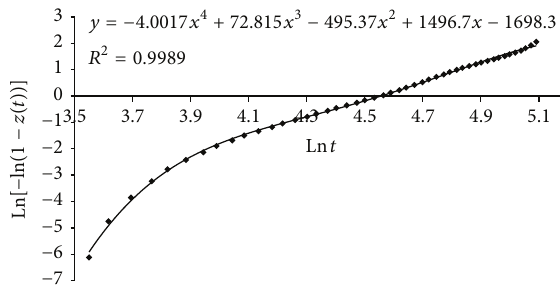
Figure 6: Plot of ln [− ln ( 1 −𝑧(𝑡))] against ln 𝑡 for In laying on PTFE 1mm thick and nominally crystallized at 156 ∘